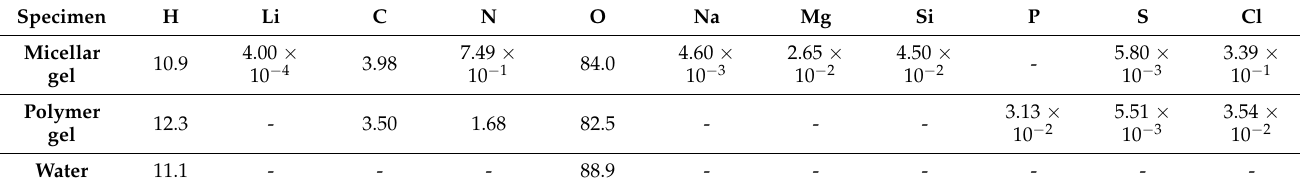
Table 4. Elemental composition (%) of the two gel dosimeters and water used in simulation.